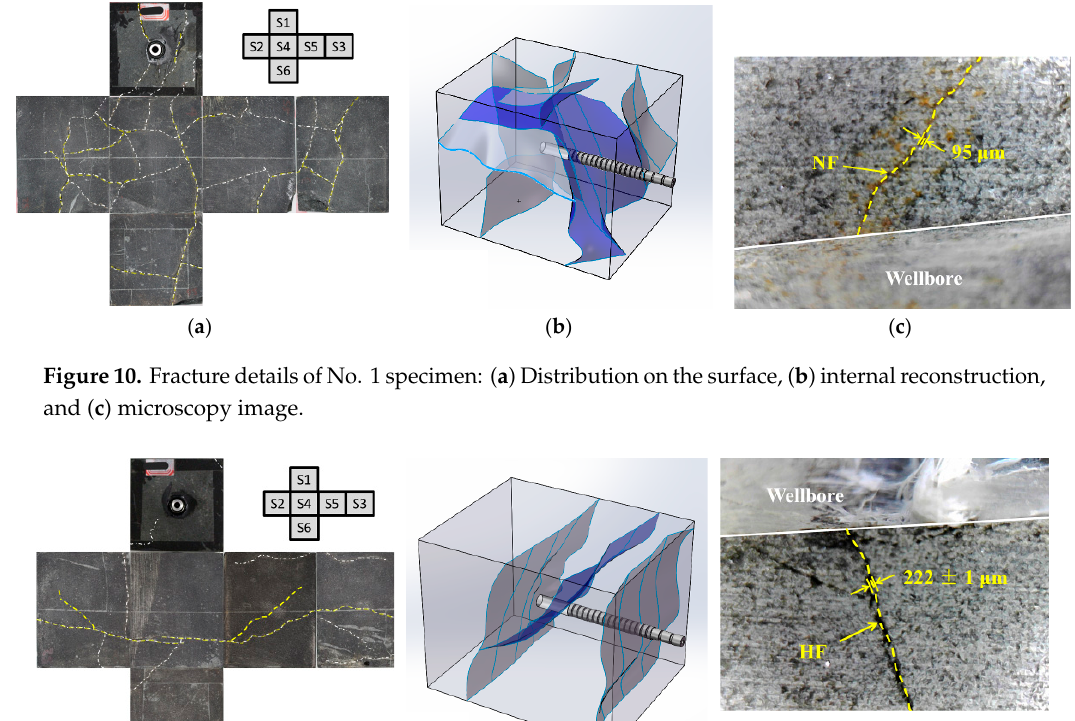
Figure 9. Pressure curves of different specimens under different injection rates: ( a ) No. 1, 0.2 mL/min; ( b ) No. 2, 2 mL/min.